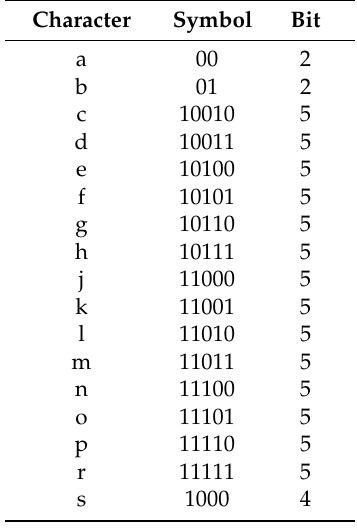
Figure 8. Huffman tree of ‘aaaabbbbcdefghjklmnoprsaabb’ text. Table 6. Symbolization of the Table 6. Symbolization of the characters.